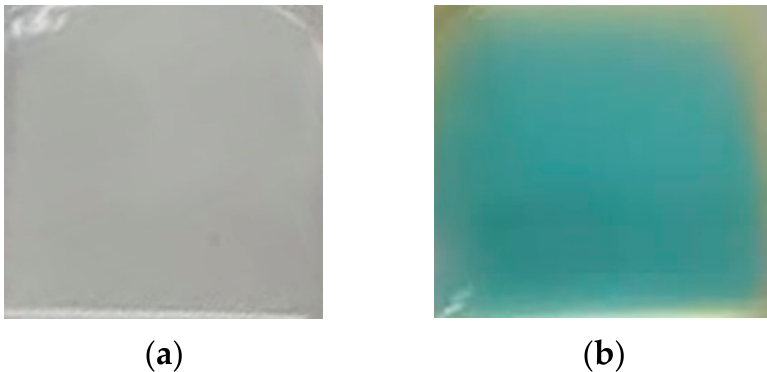
Figure 10. Immunochemical reaction of glass slides treated with antibodies labeled with horseradish peroxidase (HRP), then with HRP chromogenic substrate 3,3 ′ , 5,5 ′ -tetramethylbenzidine (TMB). ( a )—slide with immobilized Staphylococcus protein A. ( b )—slide without protein A.